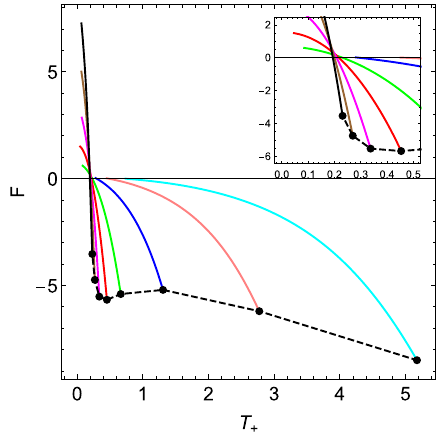
Fig. 6 Freeenergy F ofthethermalonconfigurationasafunctionofthe temperature T + for various value of λ with k = 1, L = 1, γ a = − 2 . 296, γ = 2 . 048 and γ = 0 . 1. The subplot displays the behavior of free b c energy at larger value of λ . The colored code can be found in Fig. 5